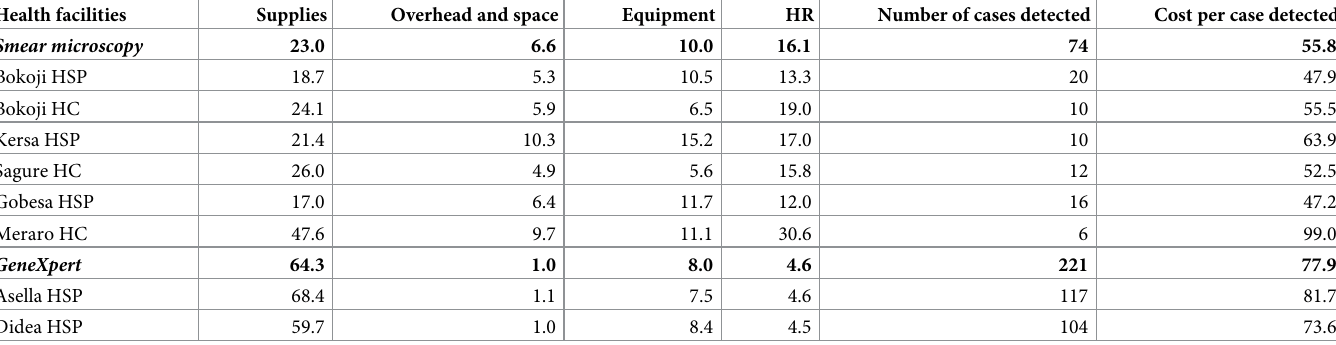
Table 3. Cost per case detected of smear microscopy and Gene Xpert diagnostic methods by health facilities in Arsi Zone, Ethiopia, 2019 (2018 US$). Health facilities